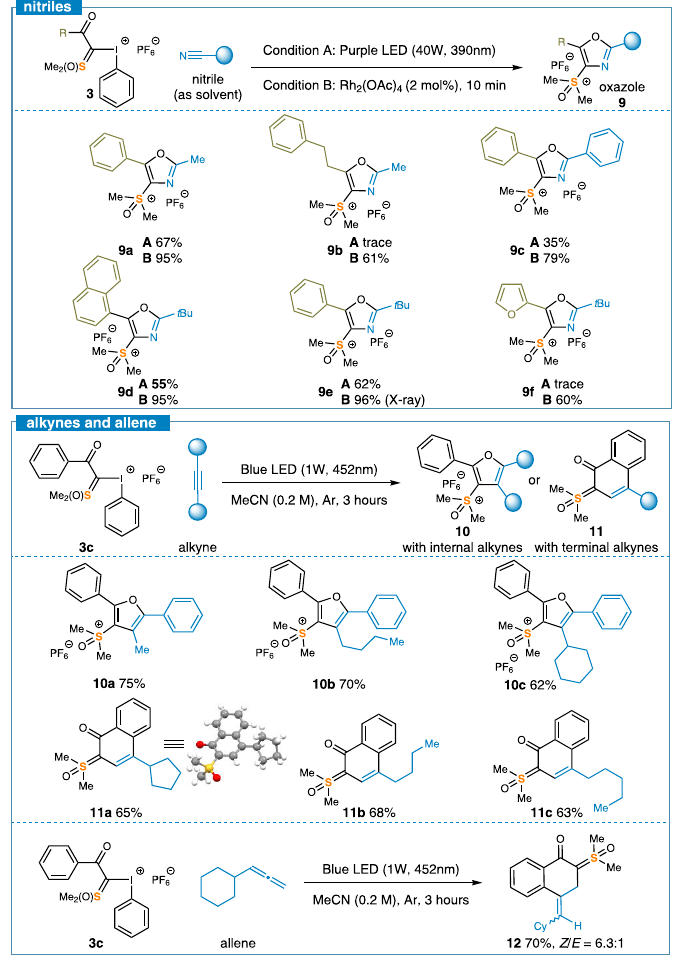
Fig. 5 | Cycloaddition of other unsaturated bonds. Condition A: Reagent 3 (0.2mmol, 1 equiv.) in 1.0mL of nitrile solvents, under irradiation of 40W purple LEDs for 3h at RT; Condition B: Reagent 3 (0.2mmol, 1 equiv.) and Rh 2 (OAc) 4 (2mol%)in1.0mLofnitrilesolvents,RT,10min;ConditionC:Alkynes(0.4mmol,2